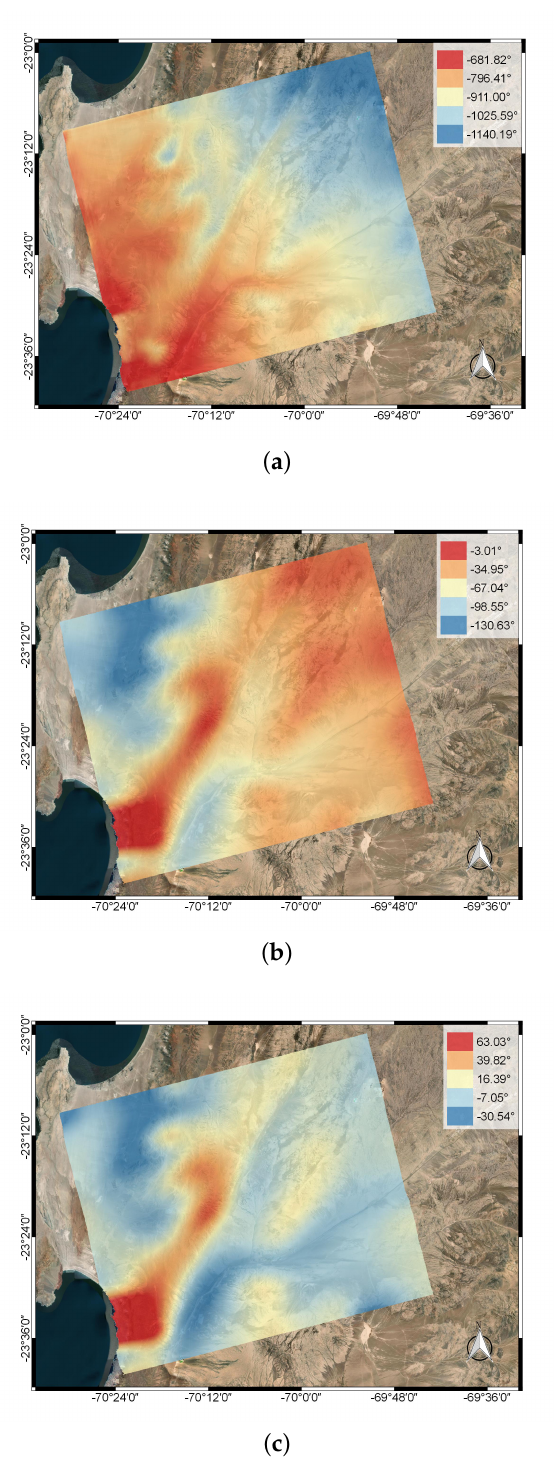
Figure 16. Ionospheric correction with height error by SSM on 20100623 and 20100808: ( a ) Ionospheric phase delay. ( b ) Corrected DInSAR phase. ( c ) Corrected DInSAR phase